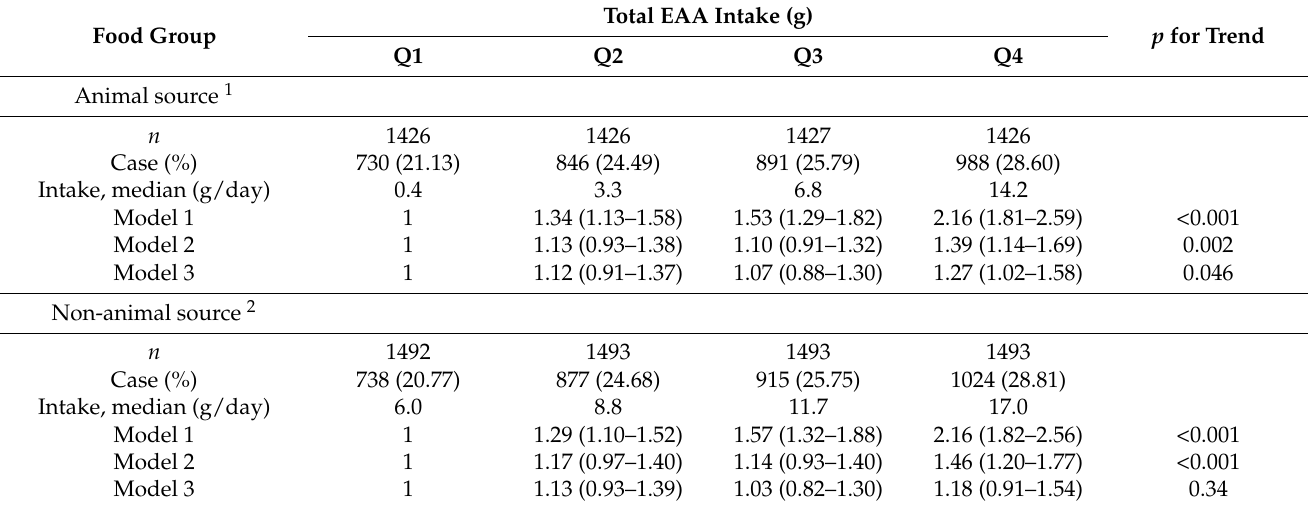
Table 4. Multivariable logistic regression analysis between total EAA intake and high muscle